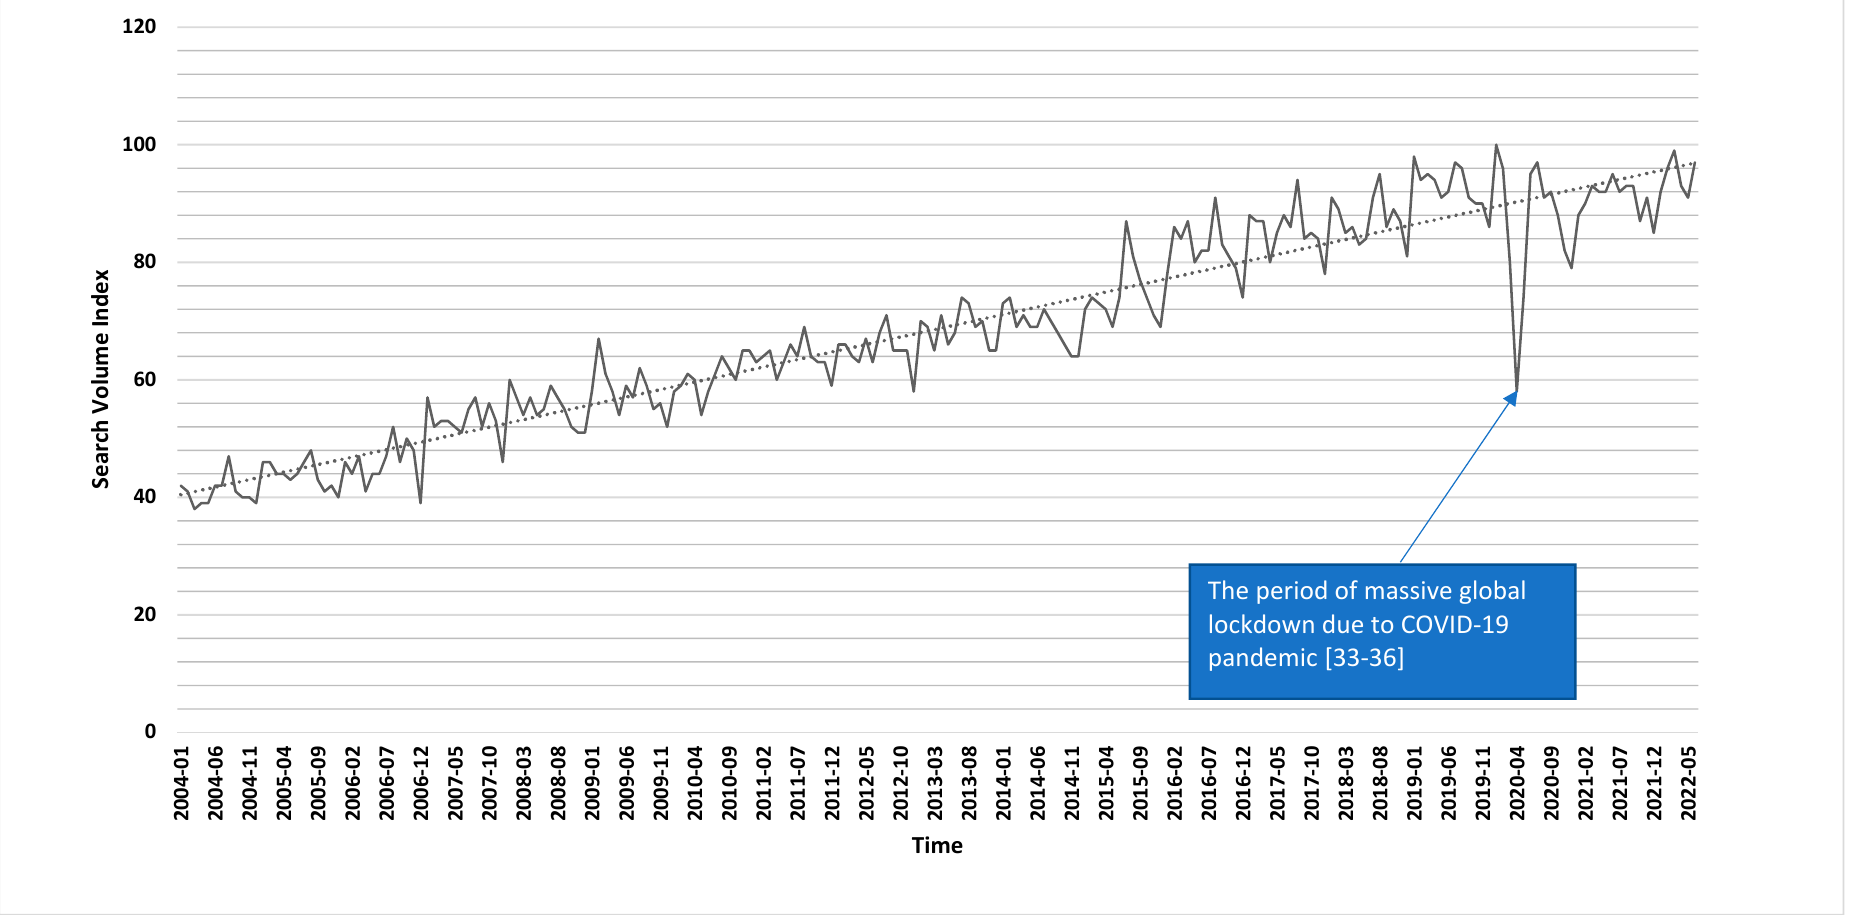
Figure 2. Trend of SVI of the search term “dentist” from 2004 to May 2022 [33–36].